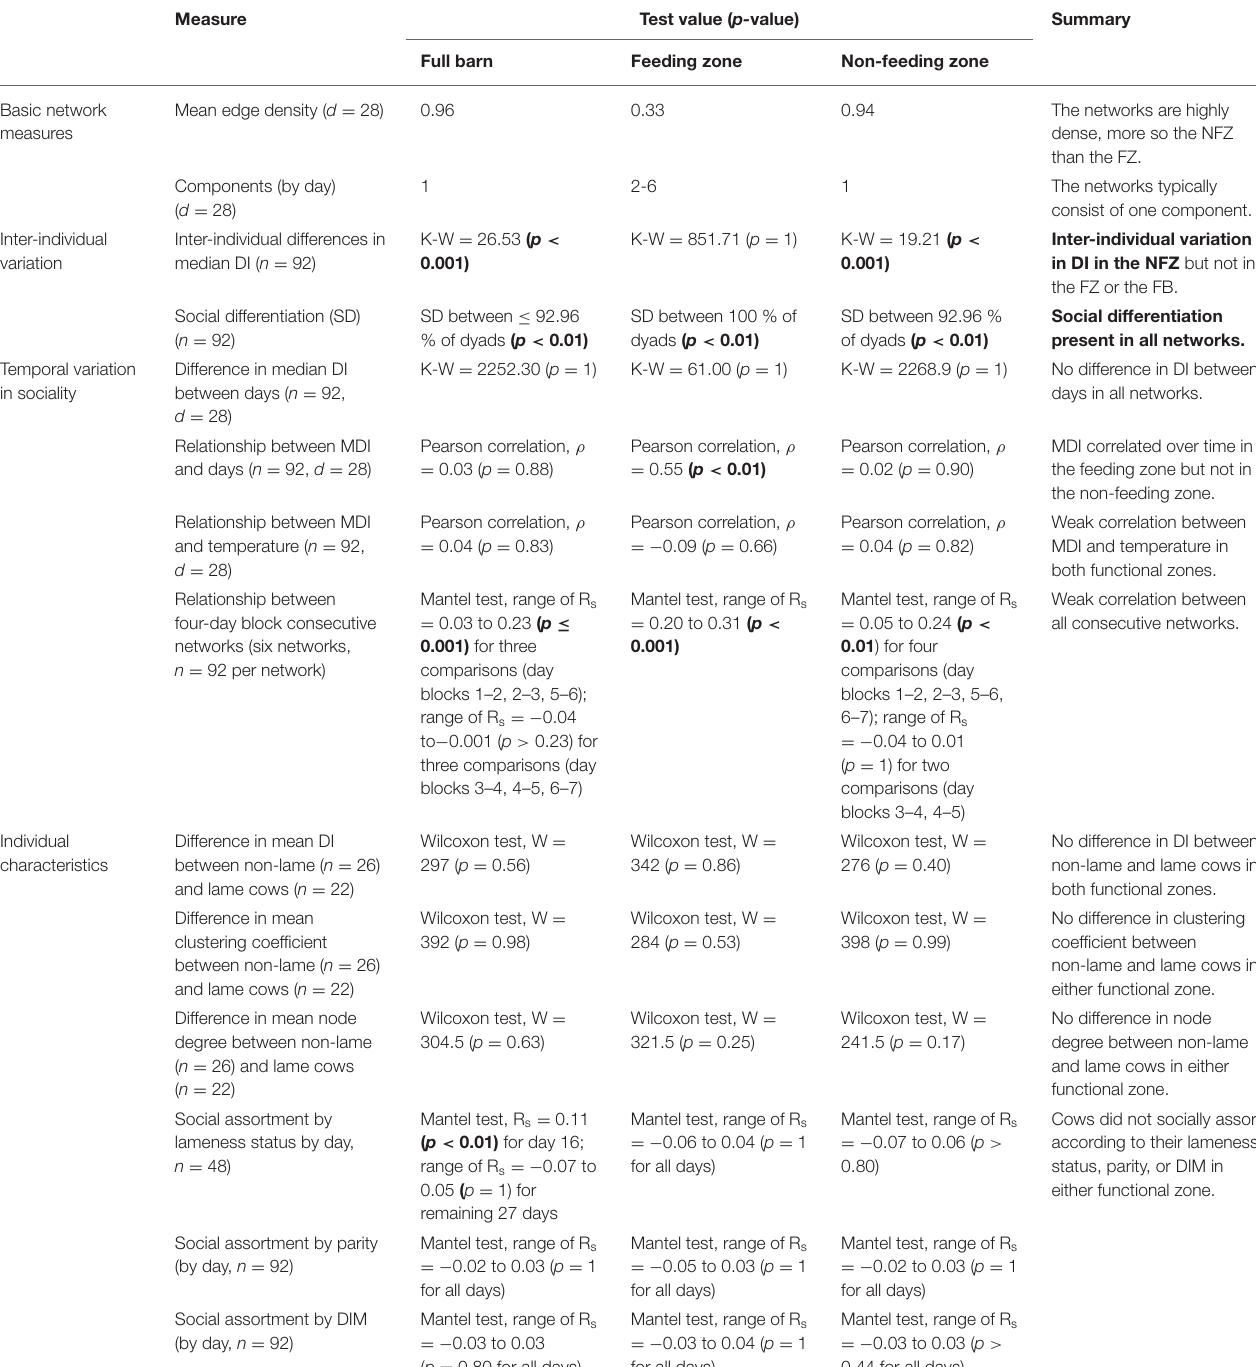
TABLE 1 | Overview of results using a spatial threshold radius of r = 3m and time duration of t = 60s to define an interaction for the full barn (FB) and the functional zones: feeding zone (FZ) and non-feeding zone (NFZ): basic network measures (original and filtered by mean degree), inter-individual variation, temporal variation in sociality, lameness status, and parity and days in milk, where (M)DI = (median) daily